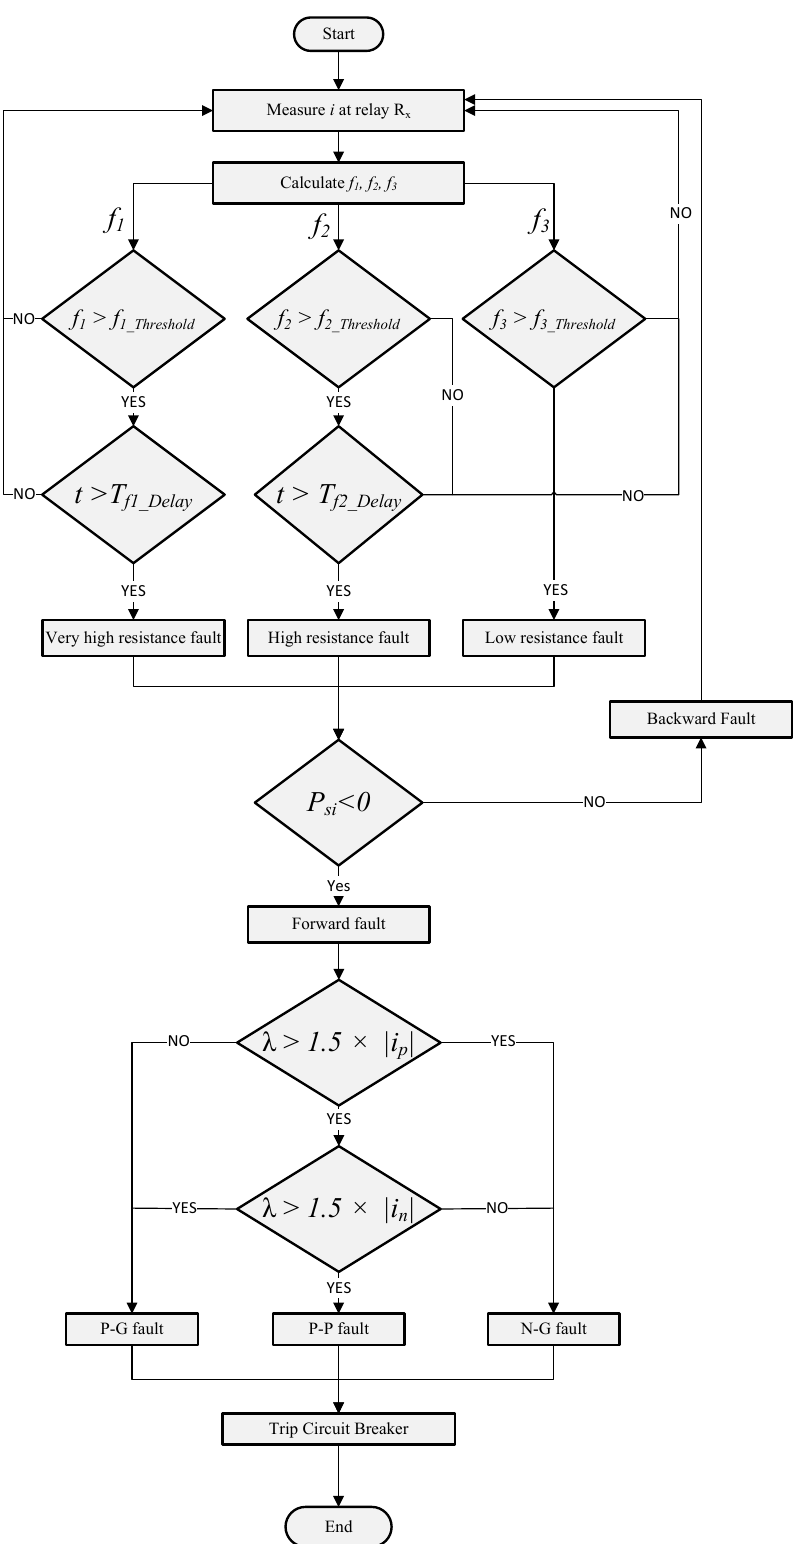
Figure 5. Flow chart of complete protection